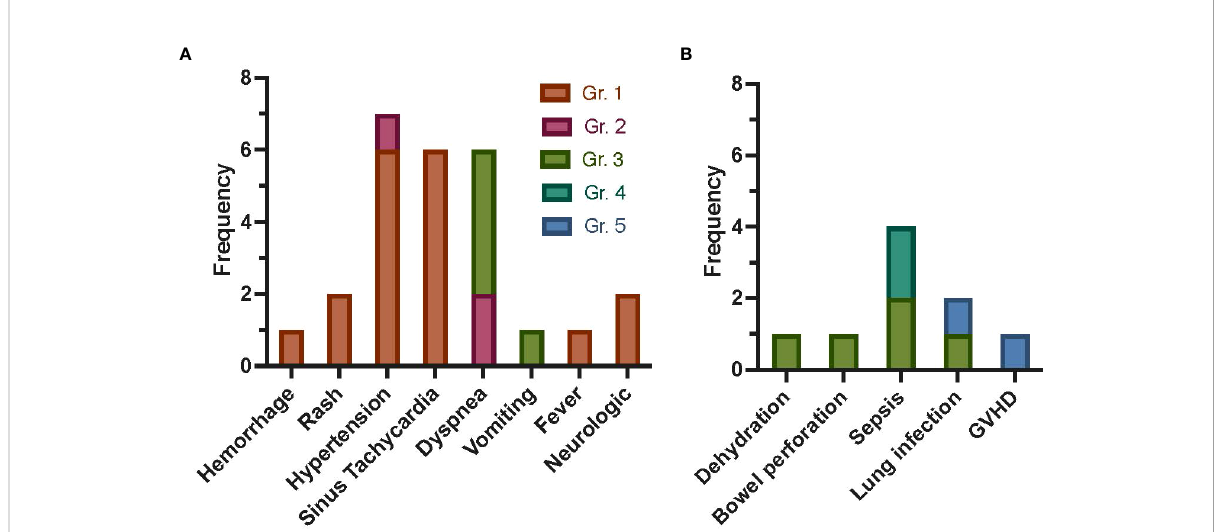
FIGURE 1 Frequency of AEs following autologous MSC infusion as treatment for refractory GVHD post-HCT for malignant disease. Targeted AEs (A) were captured within 7 days of each MSC infusion. Allergic reaction/hypersensitivity, sinus bradycardia, hypotension, rigors/chills, renal, and hypoxia are not shown, as no events occurred. The most common targeted AE was grade 1 or 2 hypertension, with four events occurring in one patient (16). Sinus tachycardia events were all grade 1, with two events occurring in patient 12 and four events occurring in patient 15. All dyspnea events occurred in two patients (n = 2 in patient 7, n = 4 in patient 16). Only three AEs were attributed to study participation: grade 1 rash possibly related, grade 1 rash possibly related, and grade 2 hypertension (30 min after MSC infusion) probably related. SAEs (B) were captured for 1 year, with the most common SAE being sepsis (n = 4). Death occurred in two patients (patients 5 and 6, due to GVHD and pneumonia and respiratory failure, respectively). All SAEs were expected and were not attributed (unlikely or de fi nitely not related) to study participation. Gr., grade; GVHD, graft-versus-host disease; AEs, adverse events; MSC, mesenchymal stromal cell; HCT, hematopoietic cell transplantation; SAEs, severe